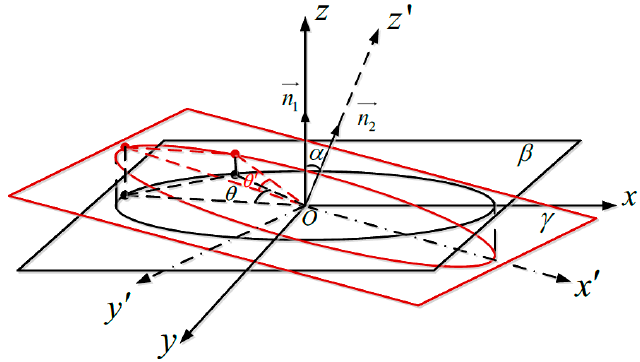
Figure 4. Schematic diagram of the angle between the rotating axis and the normal line of the working plane of the rotary table.